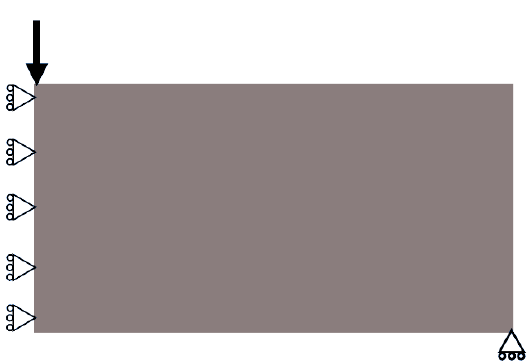
Figure 11. Schematic of the MBB structure problem definition.